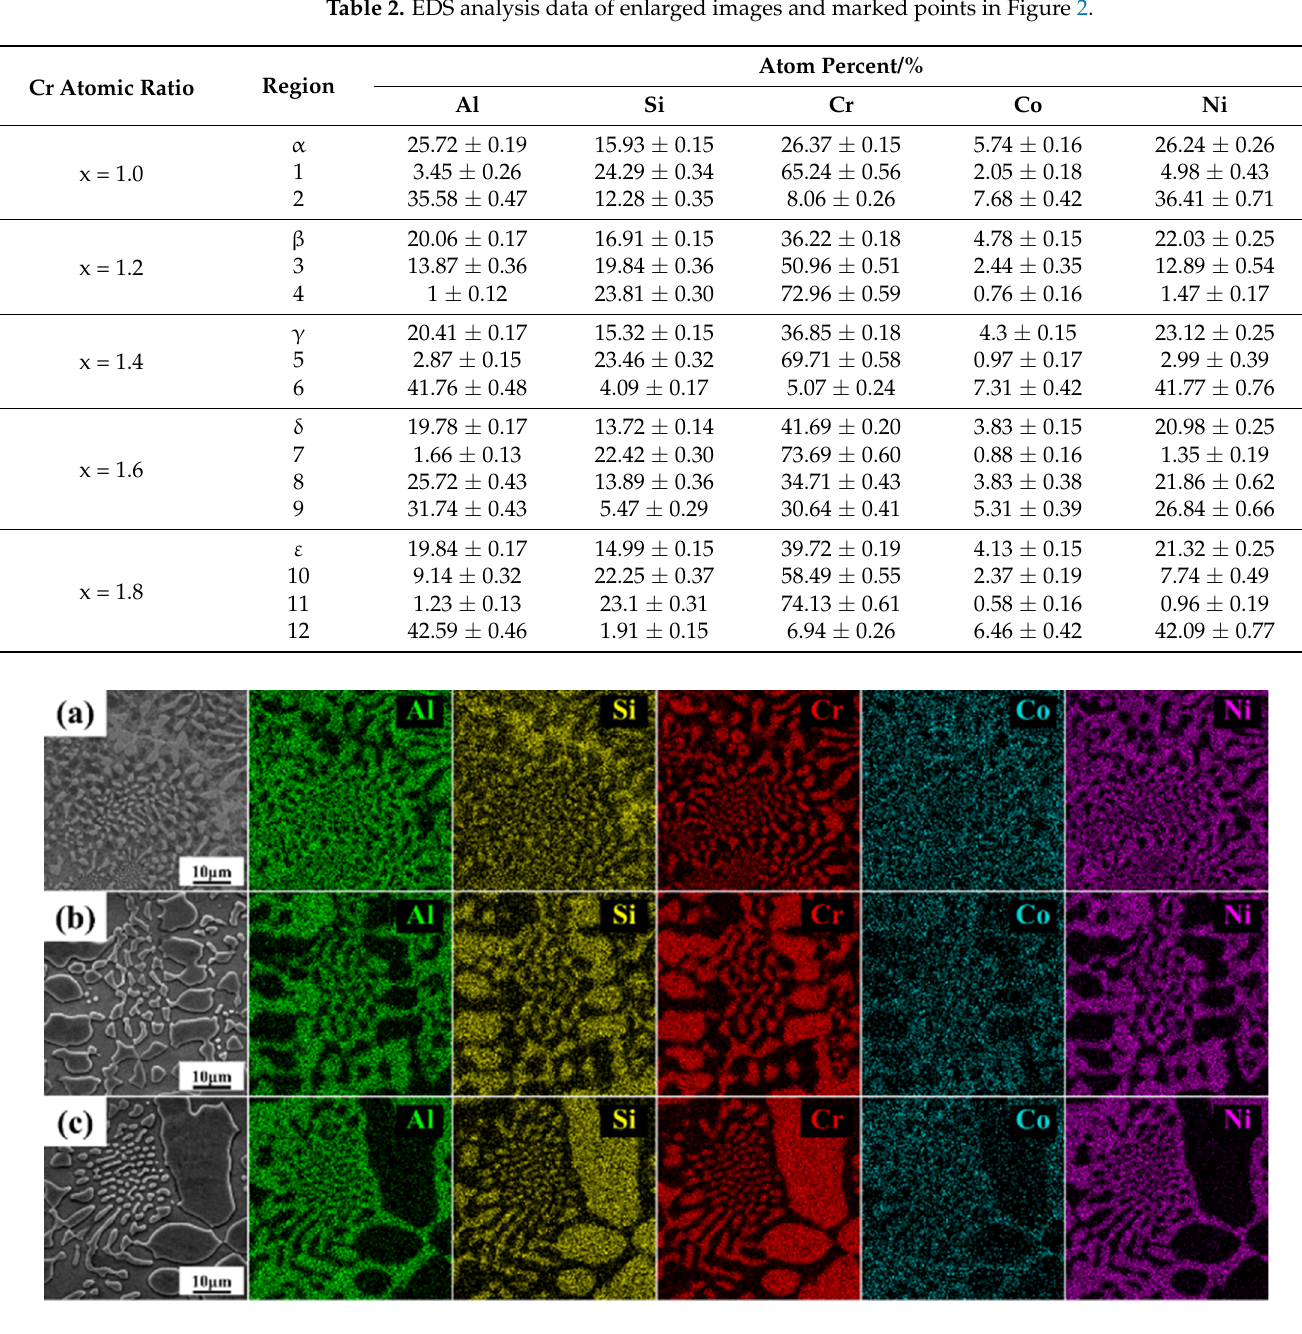
Figure 3. EDS elemental mapping of AlSi 0.5 Cr x Co 0.2 Ni high entropy alloys; ( a ) x = 1.0, ( b ) x = 1.4, ( c ) x = 1.8.